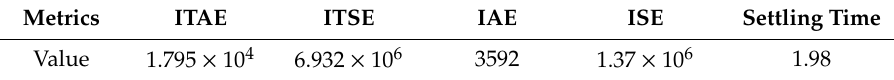
Table 12. Results for the PI controller.